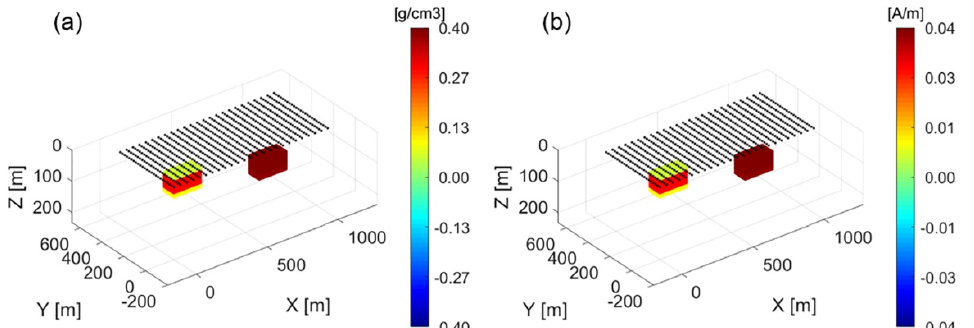
Figure 1. Panels ( a , b ) show 3D views of the true density model and vertical component of magnet- ization vector model, respectively. The black dots represent the location of the observation sta-